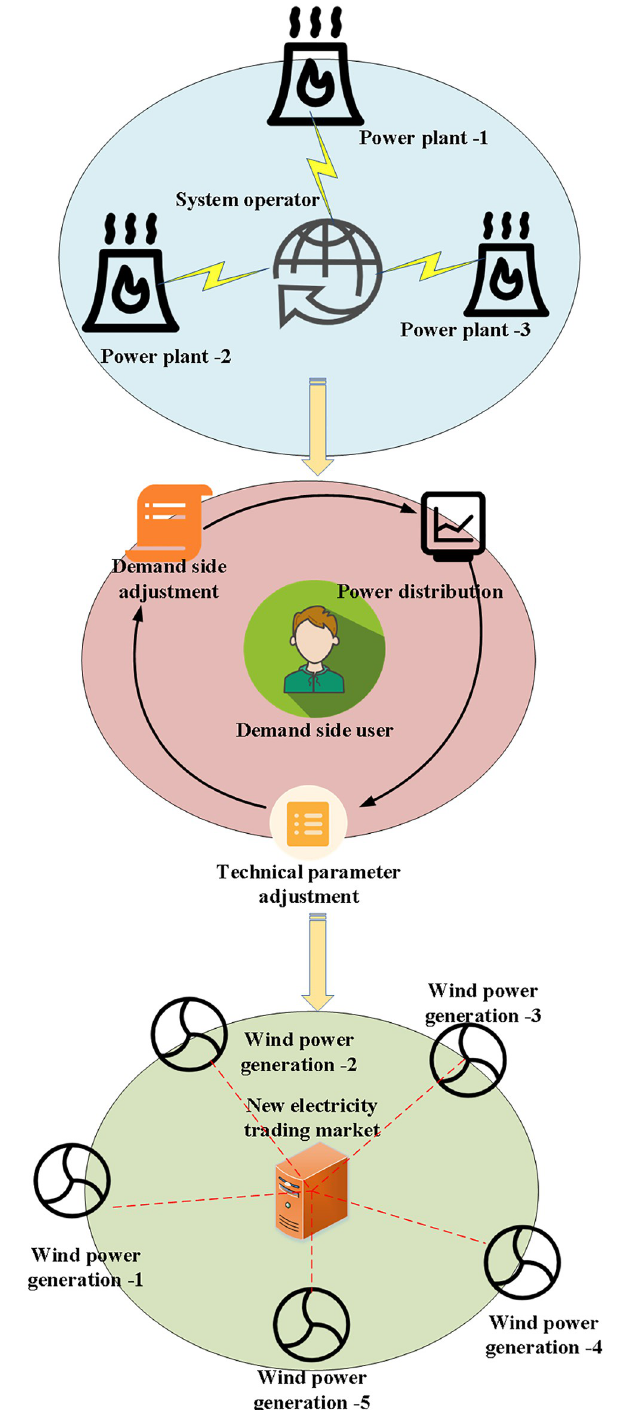
Fig 3. Equilibrium value distribution strategy of virtual power plant in cooperative game.